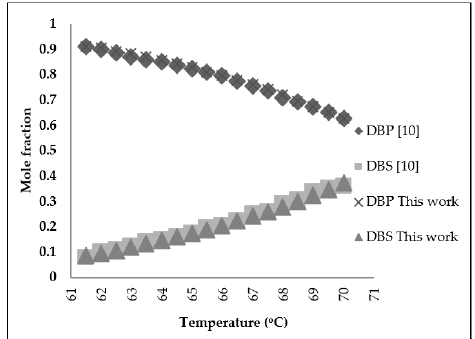
Figure 2. Comparison of distillate mole fraction in study [10] and this work as a function of flash vessel operating temperature (°C).